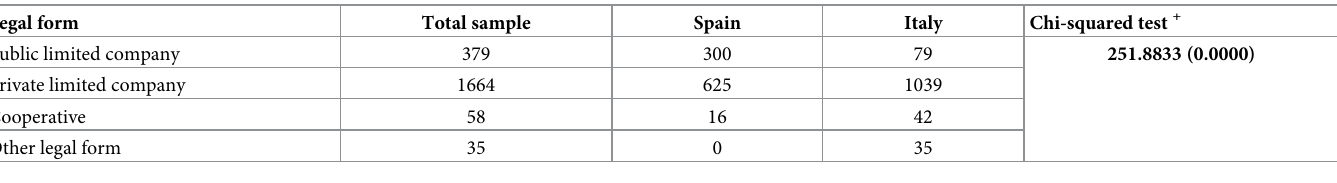
Table 3. Legal form by